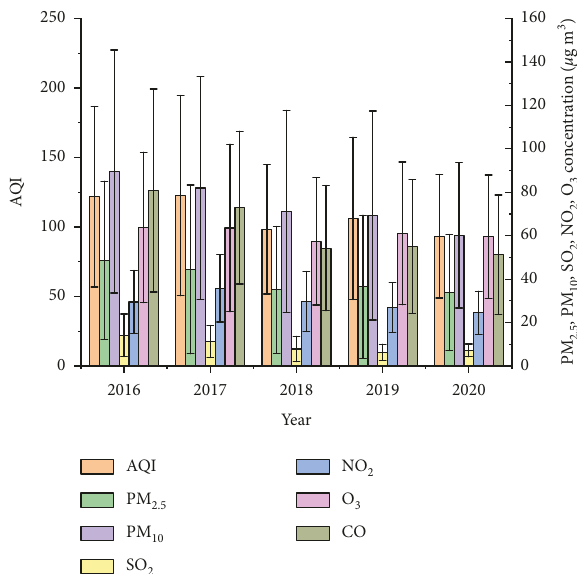
Figure 2: Variations of AQI and air pollutants annual mean values in Weinan city (for the convenience of calculation, the CO con- centration in the figure is expanded by 100